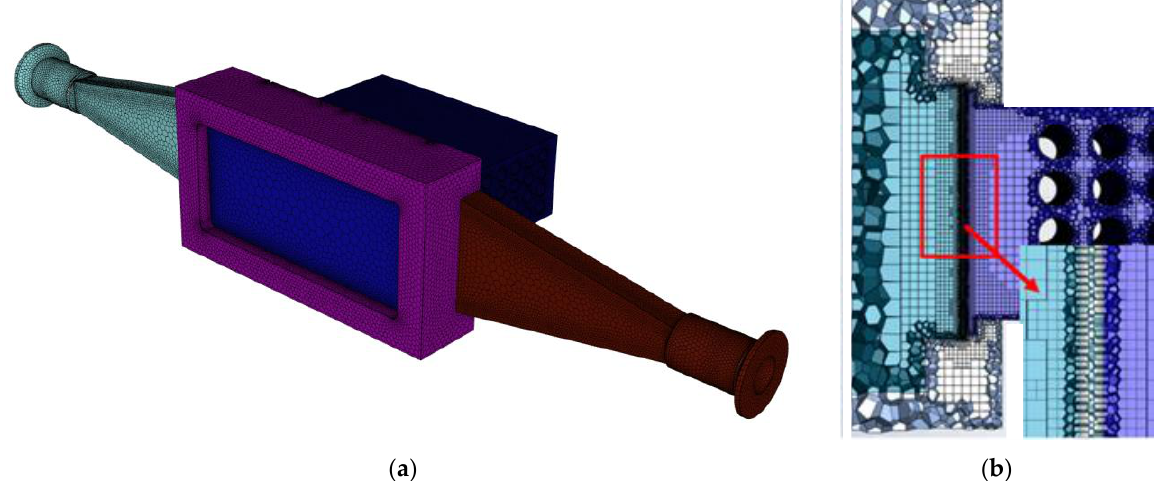
Figure 5. Mesh used in the numerical simulations: ( a ) integrate grid for experimental equipment; ( b ) local fluid grid. Table 1. Physical properties of cooling